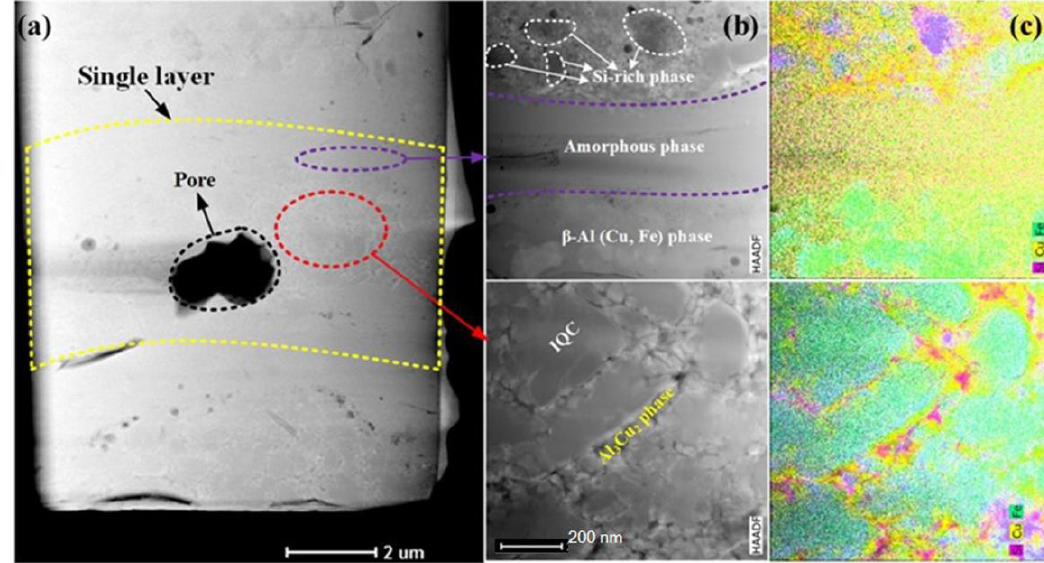
Figure 6. ( a ) Overview of coating sample for TEM investigation; ( b ) HAADF images of the amorphous and quasicrystalline phase (QC) areas; ( c ) Si-Cu-Fe maps related to ( b ).